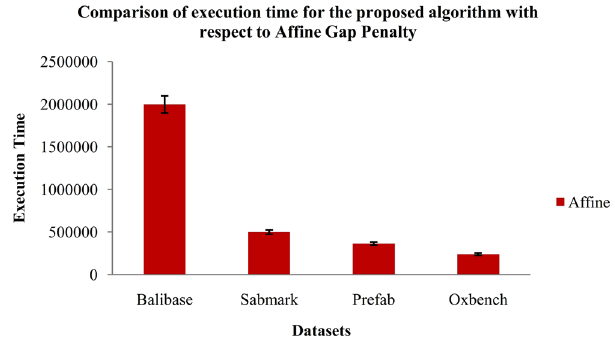
Figure 11. Execution time for the proposed BFO-GA algorithm with respect to Affine Gap Penalty.